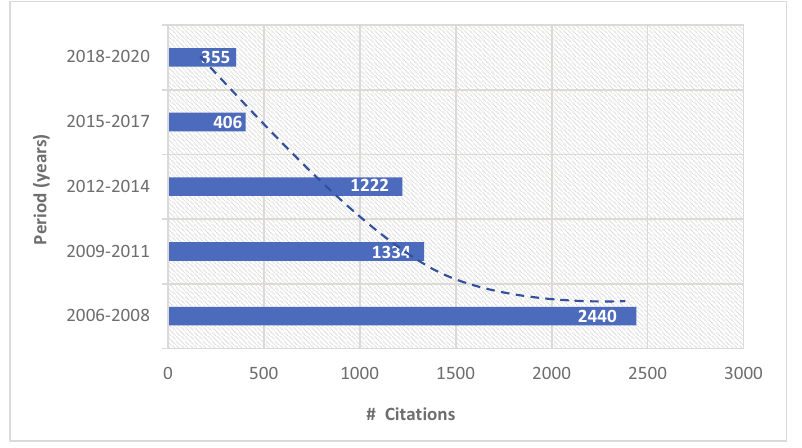
Figure 4. Citations, each three years of the surveyed